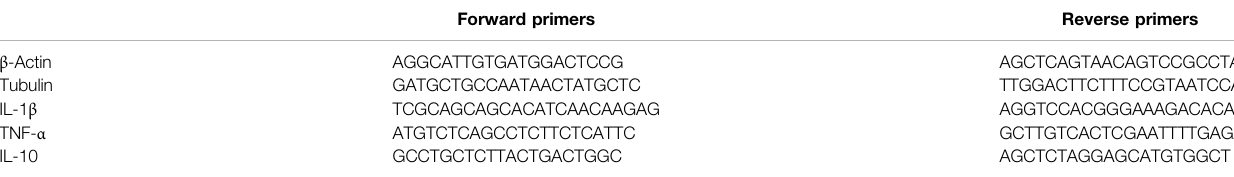
TABLE 1 | Speci fi c primers used for